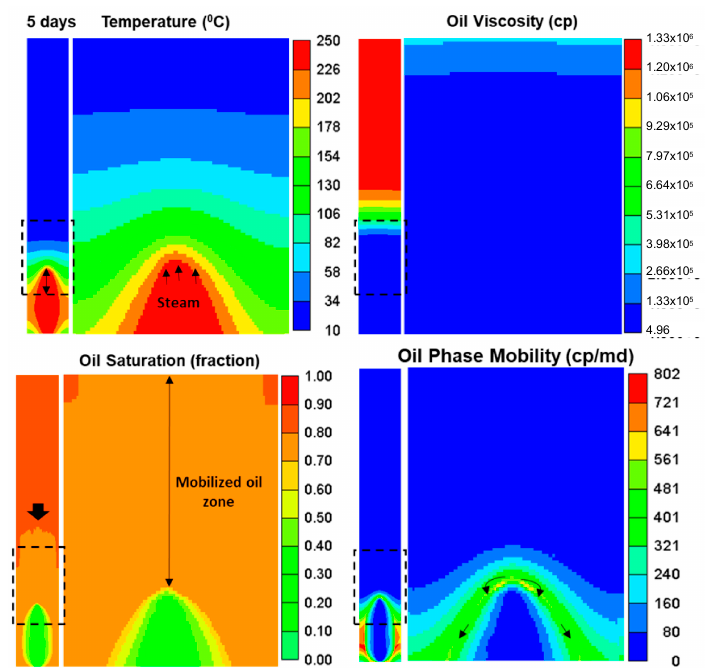
Figure 18. 2D images of the temperature, oil viscosity, oil saturation and oil phase mobility distributions in the VE model after 8 hours of steam injection. Zoomed in views are displayed of the region enclosed by the dashed black line square.